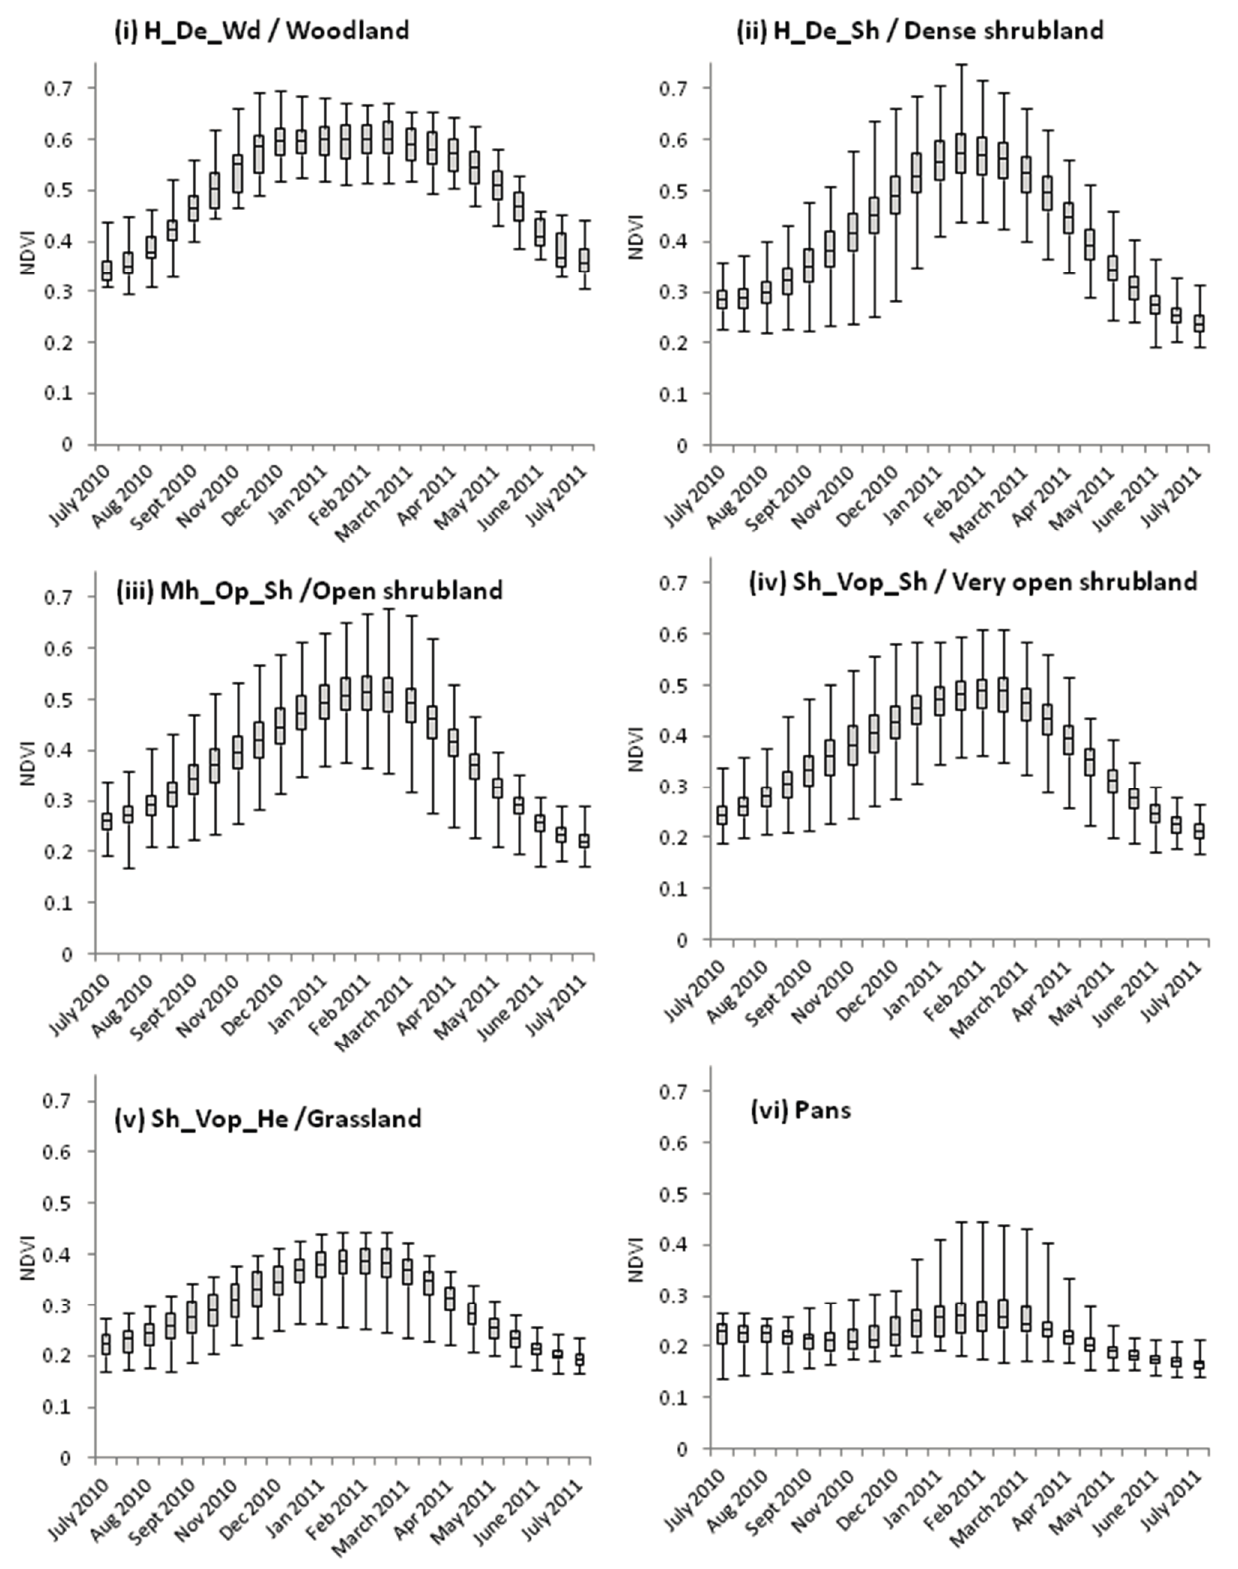
Figure 4. NDVI temporal profiles of samples of each vegetation morphology type showing differences in NDVI magnitude and phenological properties for the year